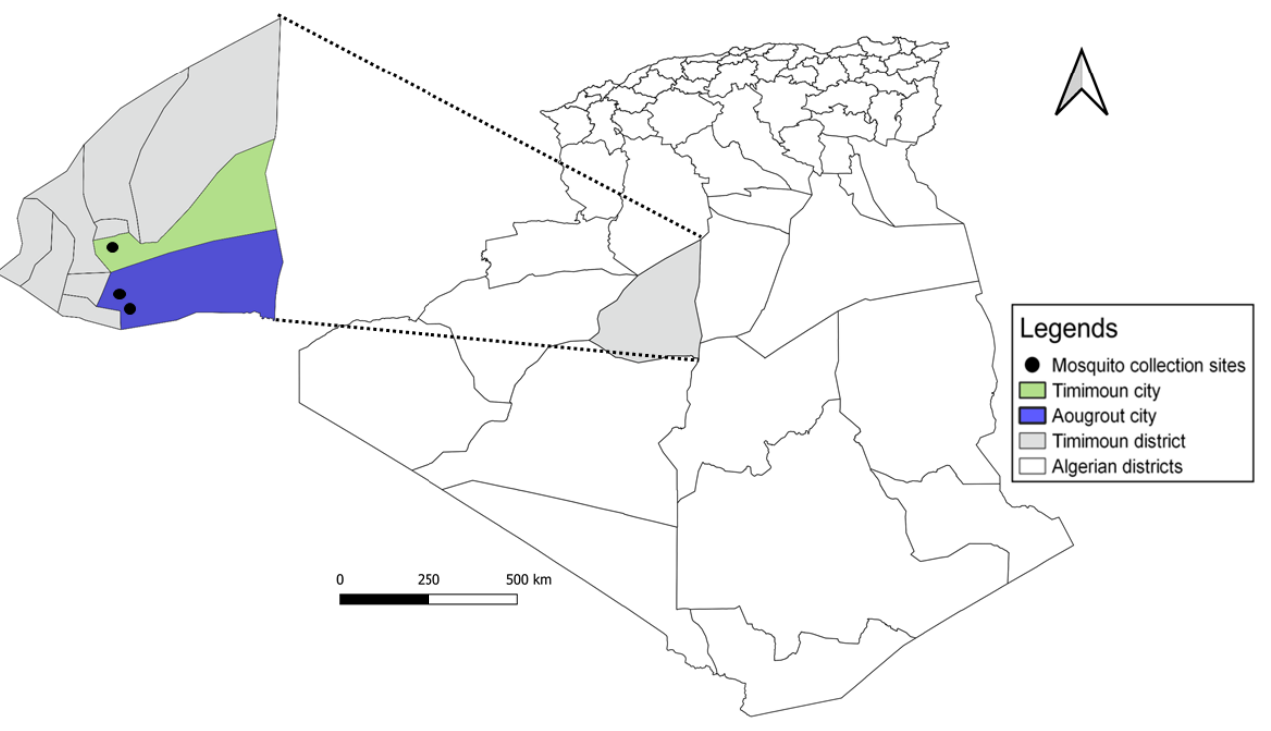
Figure 1. Mosquito collection sites in Algeria.